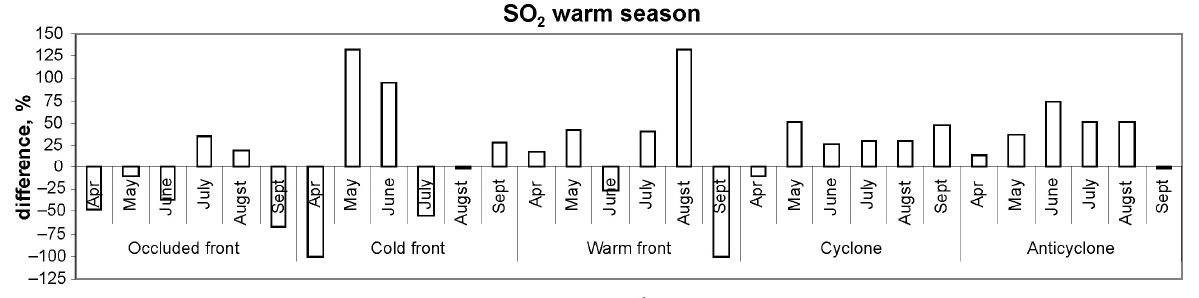
Fig 4. Difference between SO 2 three-year monthly average and average concentration during cold season at Preila background station